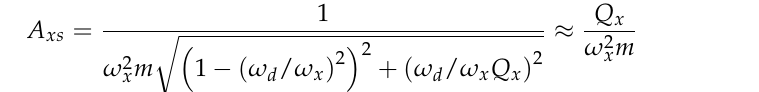
Figure 5. Effect of ϕ x and ϕ y on ZRO 2